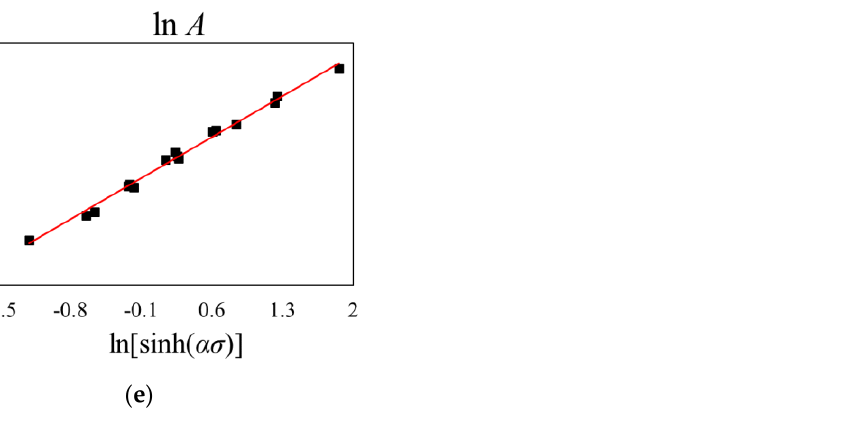
. Figure 5. Relationships between σ , ln σ , ln ε ̇ , 1000/ T , ln [sinh( ασ )] and ln Z : ( a ) σ – ln ε ̇ , ( b ) ln σ – ln ε ̇ , Figure 5. Relationships between σ , ln σ , ln ε , 1000/ T , ln[sinh( ασ )] and ln Z : ( a ) σ –ln . ( c ) ln [sinh( ασ )] – ln ε ̇ , ( d ) ln [sinh( ασ )] − 1000/ T , ( e ) ln Z − ln [sinh( ασ )]. ε , ( d ) ln[sinh( ασ )]–1000/ T , ( e ) ln Z –ln[sinh( ασ )]. ( c ) ln[sinh( ασ )]–ln